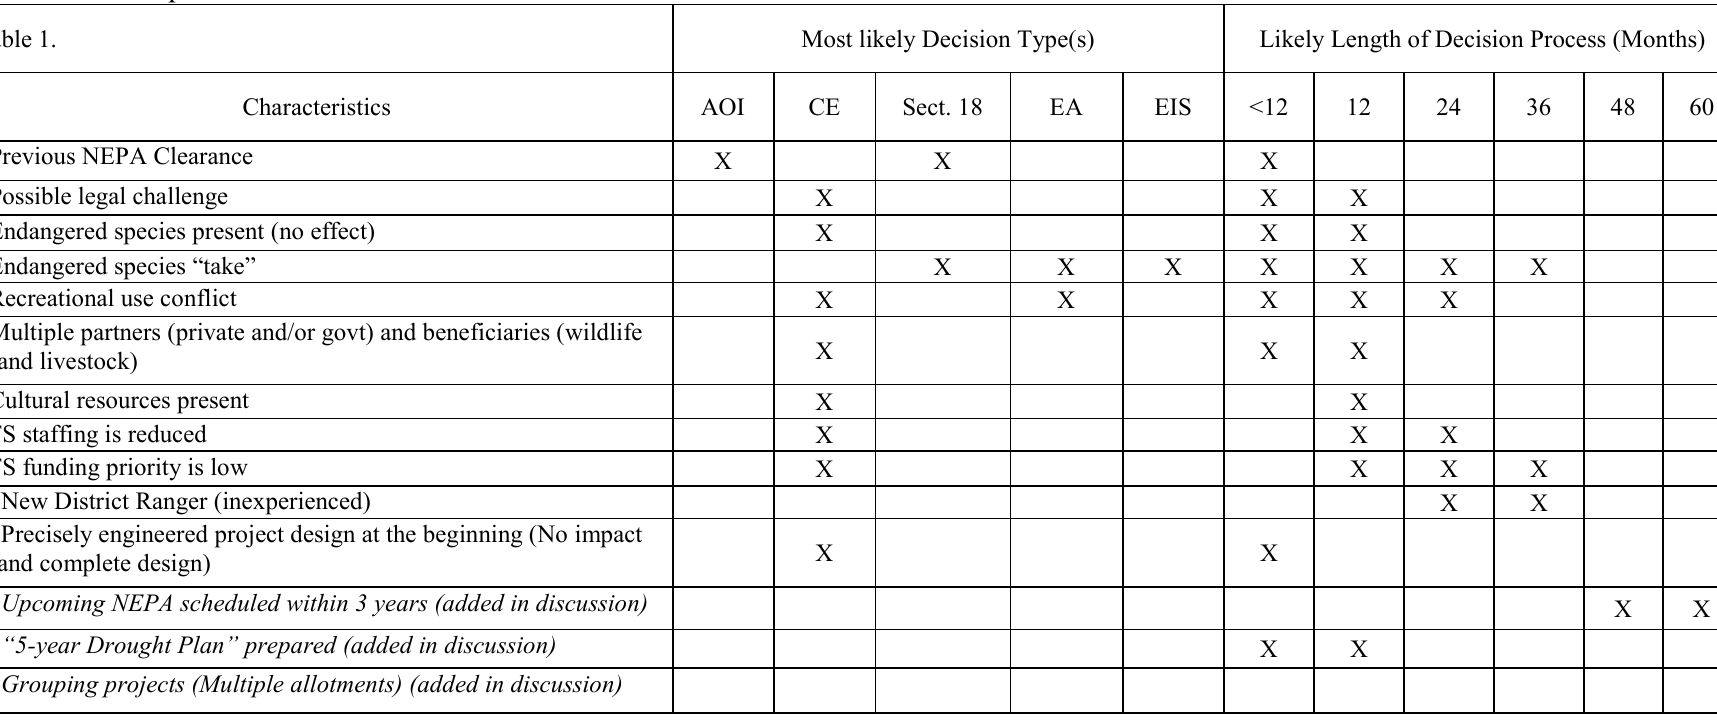
Table A1.3: Decision Table for FS decision process for a water development